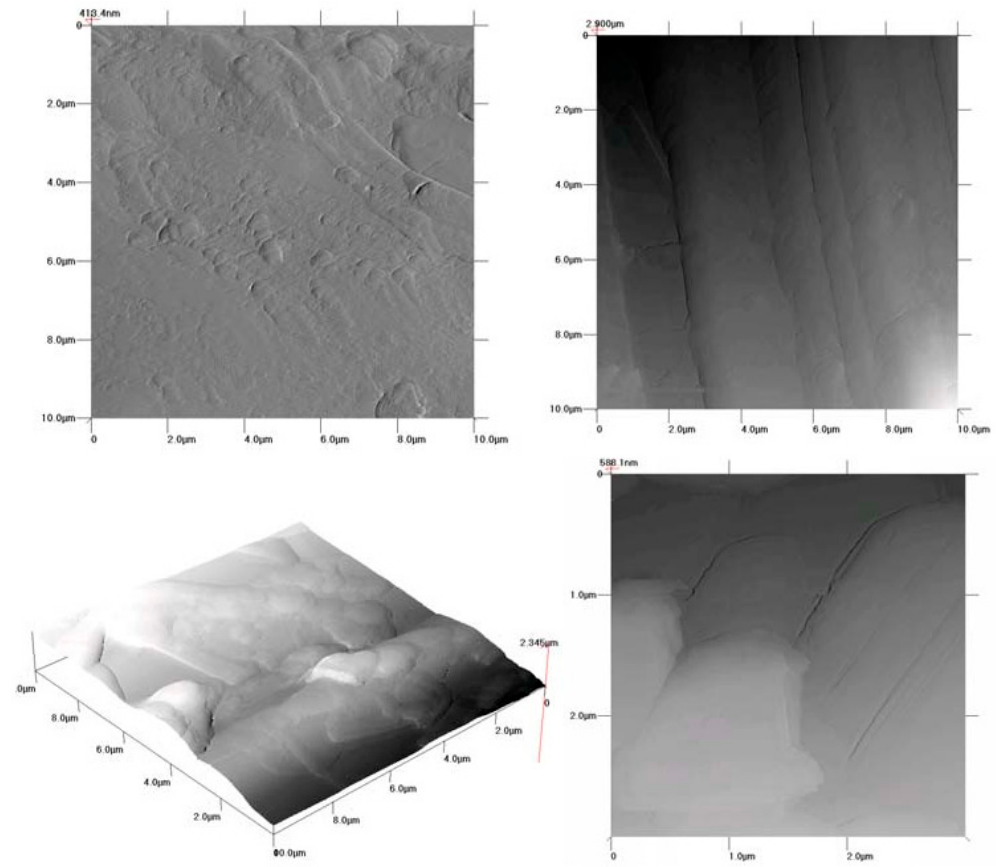
Figure 8. AFM Images of faces of molybdenite particles used for contact angle measurements [31,32].